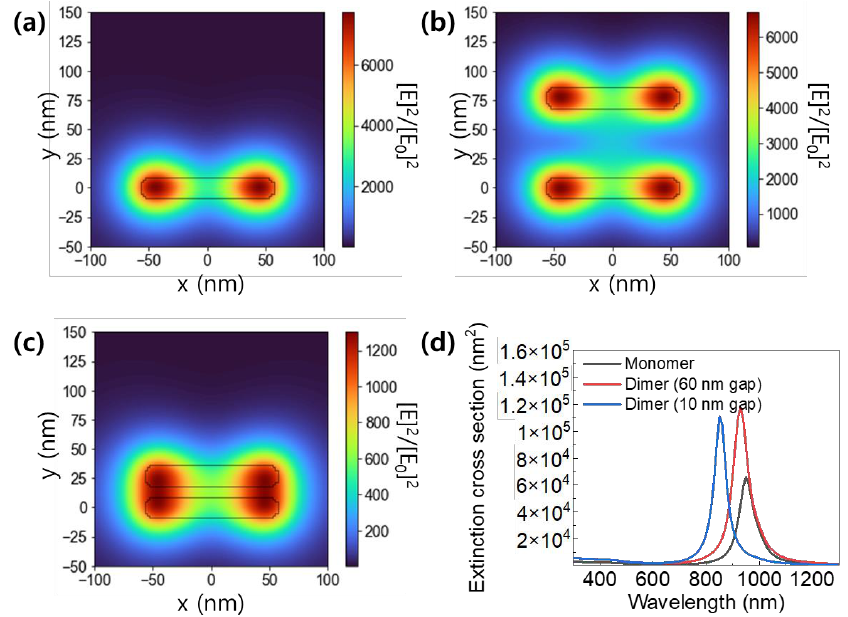
Figure 4. Electric field simulation via pyGDM for ( a ) a single Au nanorod, ( b ) two Au nanorods with 60 nm spacing, and ( c ) two Au nanorods with 10 nm spacing. ( d ) Comparison of the simulated extinction spectrum of each nanorod placement.